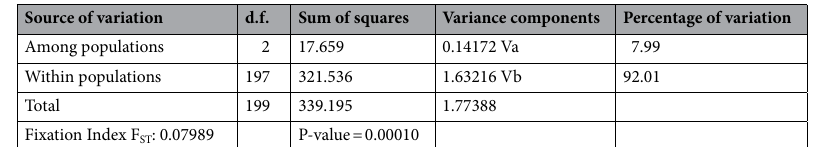
Table 3. Analysis of molecular variance (AMOVA) based on mtDNA data from Sardinian cattle breeds.